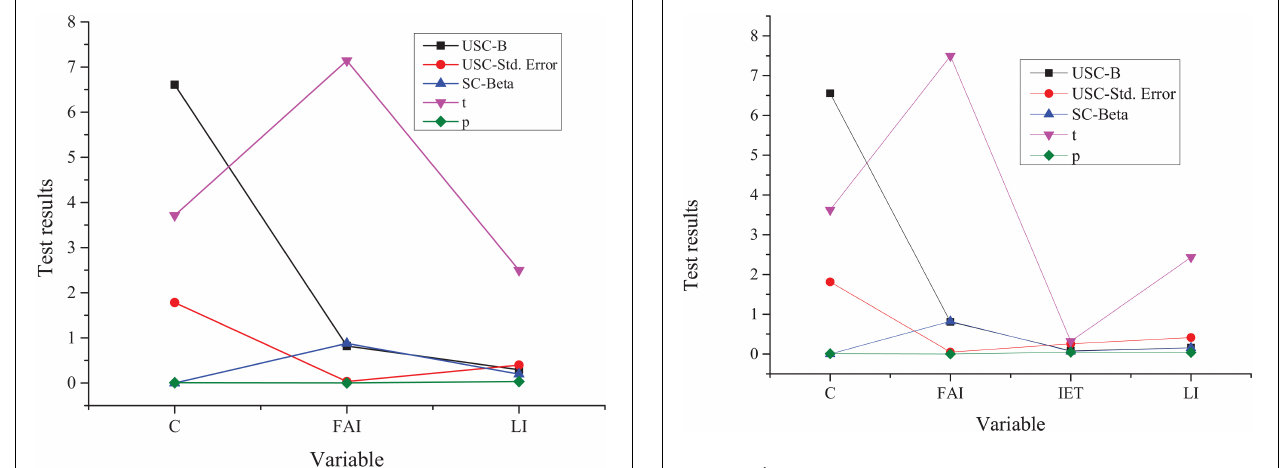
FIGURE 8 | Model test results after introducing innovative and entrepreneurial talents. IET, innovative and entrepreneurial